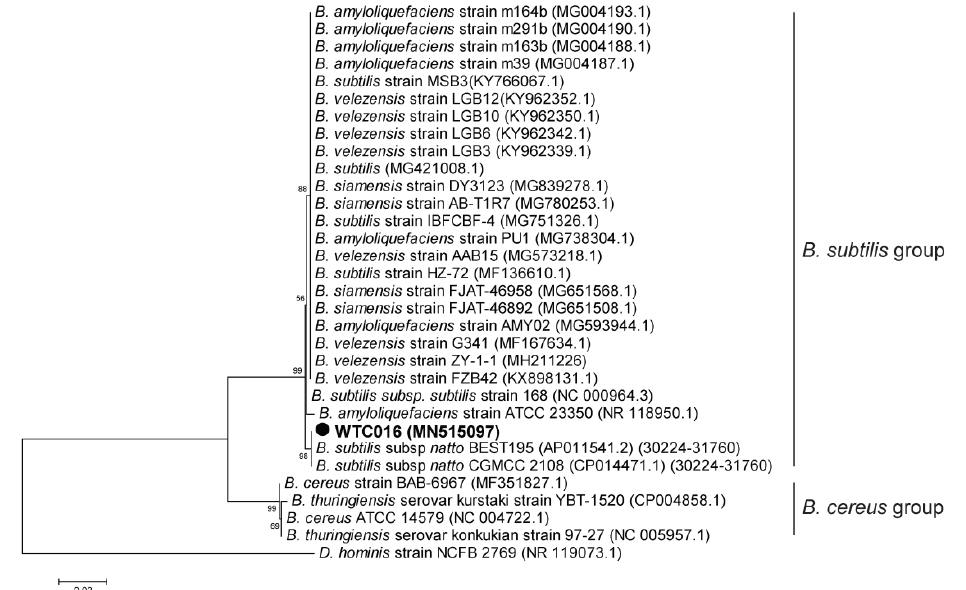
Figure 3. Phylogenetic tree based on the partial 16S rRNA of WTC016 and other homologous Bacillus strains. The phylogenetic tree was constructed using the maximum likelihood method by MEGA5 [32]. The Gen-Bank accession numbers of all the sequences are indicated in parentheses. The bar represents 0.02 substitutions per site. Dermabacter hominis ( D. hominis ) strain NCFB 2769 was used as the outgroup.